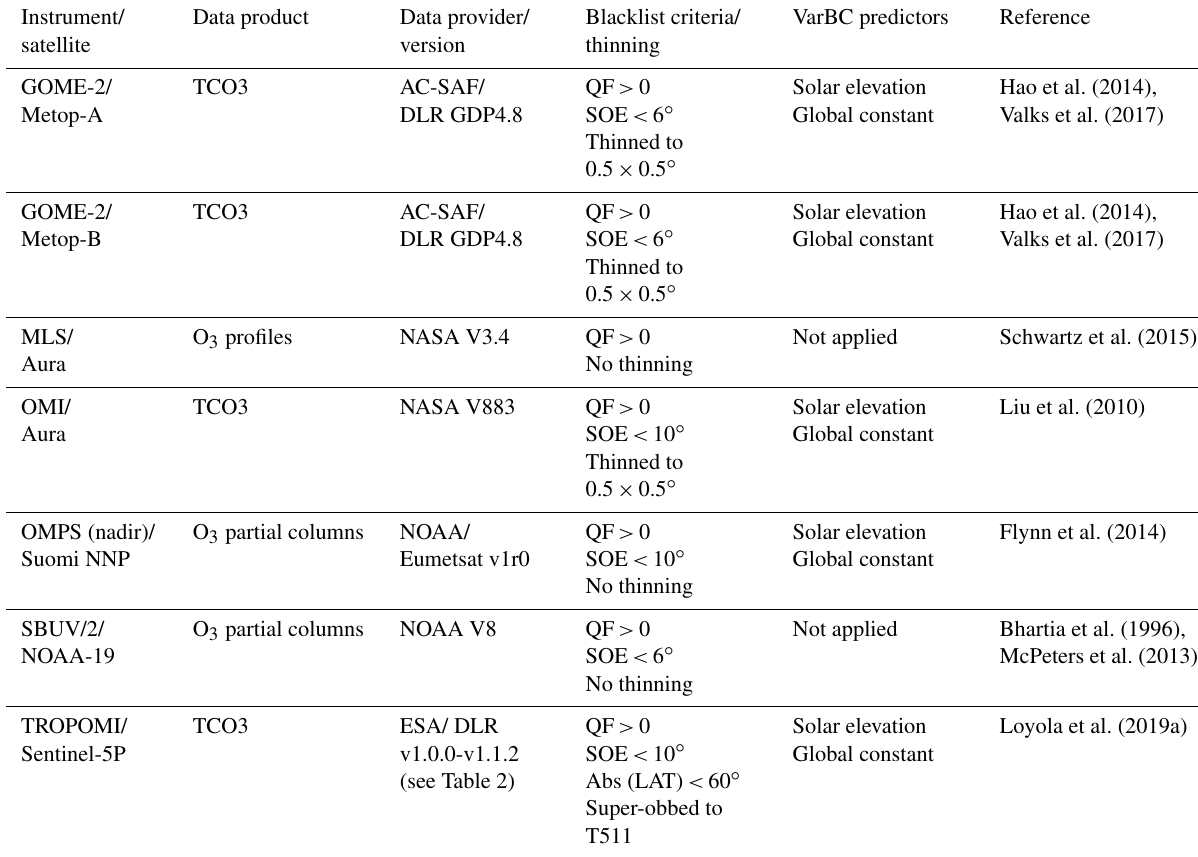
Table 1. O 3 satellite retrievals used in this paper. QF is quality flag given by data providers, SOE is solar elevation, LAT is latitude, VarBC is variational bias correction. The blacklist criteria describe when data were not